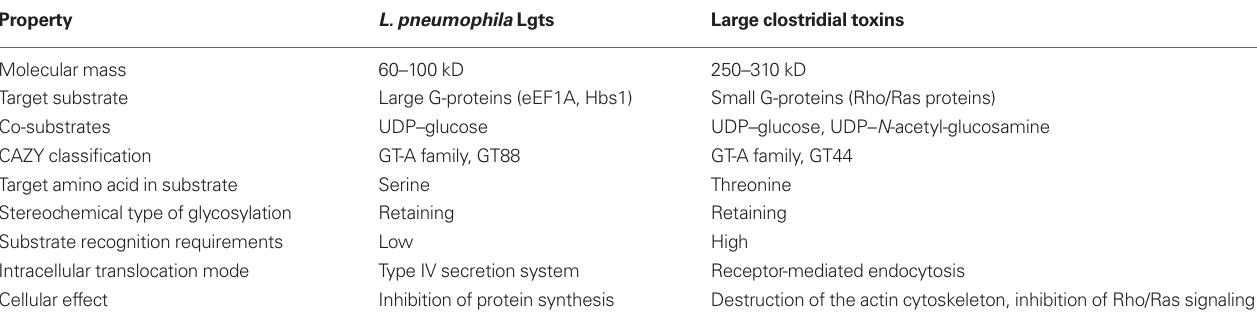
Table 1 | Comparison of glucosyltransferases Lgt from L. pneumophila with large clostridial